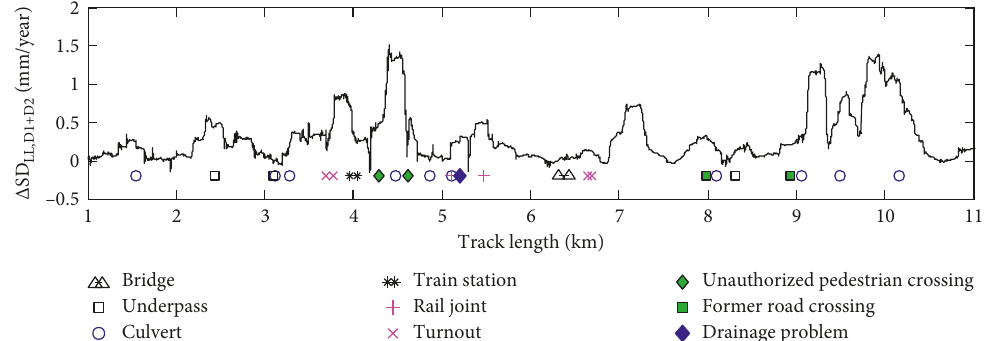
Figure 6: Evolution of standard deviation of the longitudinal level ( Δ SD